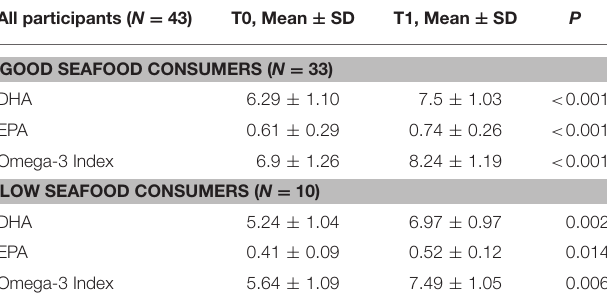
TABLE 4 | DHA levels, EPA levels and omega-3 index in RBC membranes in “good” and “low seafood consumers” at baseline (T0) and after DHA supplementation